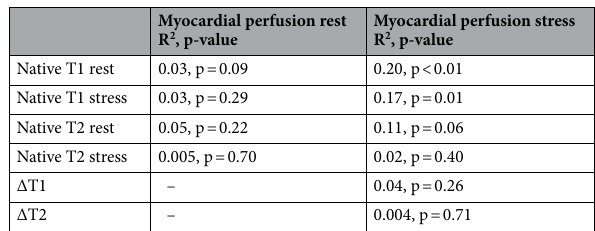
Table 4. Relationship of native T1 and T2 with myocardial rest and stress